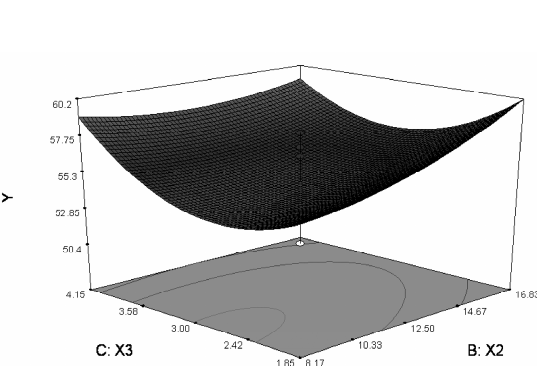
Figure 2. Response surface and contour plots based on entrapment efficiency ( Y , %) as a function of the investigated factors: phospholipid-to-drug ratio ( X 1 , g/g), reaction concentration of PPD ( X 2 , mg/mL) and reaction time ( X 3 , h).